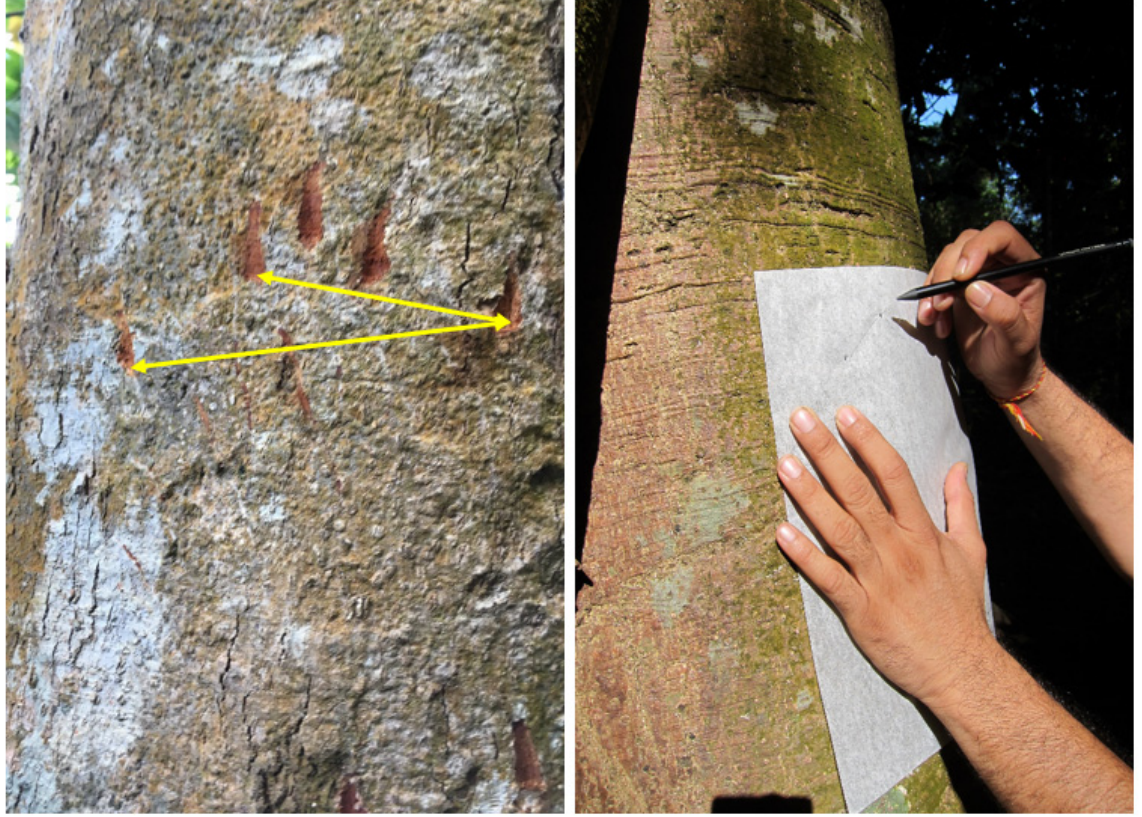
Figure 3. Measurements of hind foot claw marks of bears (marks perpendicular to the tree trunk— left panel) were used to try to distinguish black bears from sun bears. We held a paper over the claw marks and created a permanent template by punching holes at the bottom of each mark ( right ). On this template we measured spacing of the narrowest span across four claws, and the span across all five claws (if all five claws were visible) (yellow arrows). We distinguished whether claw marks were recent (as shown here), based on the color and extent of regrowth of the bark.